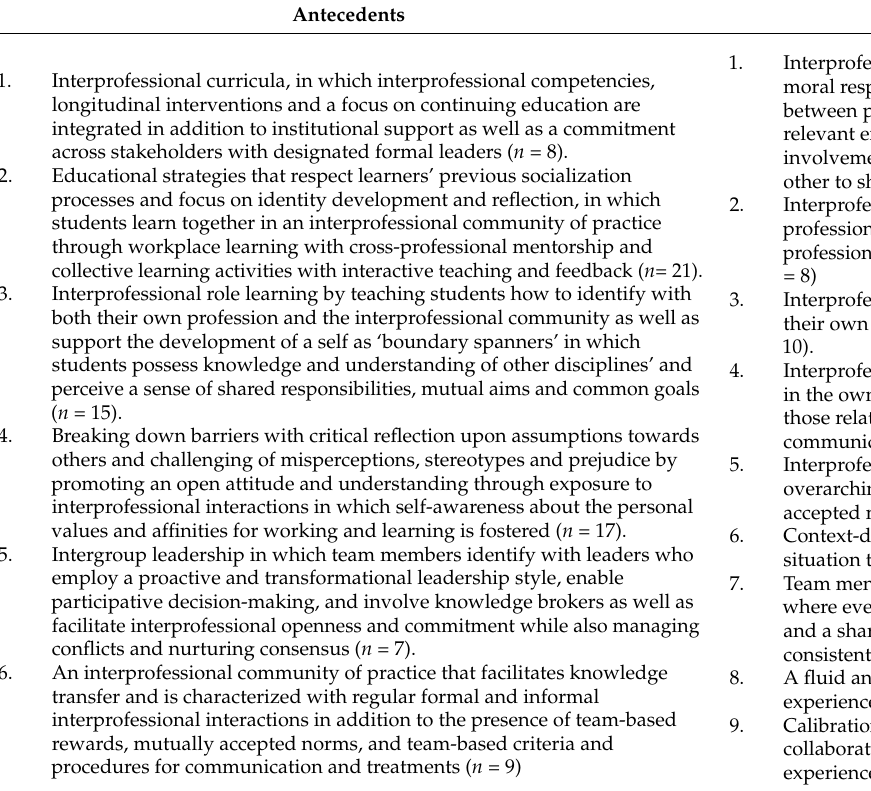
Table 1. Synthesis of attributes, antecedents and consequences of IPI ( n = number of grouped articles from which results was extracted). Antecedents Attributes